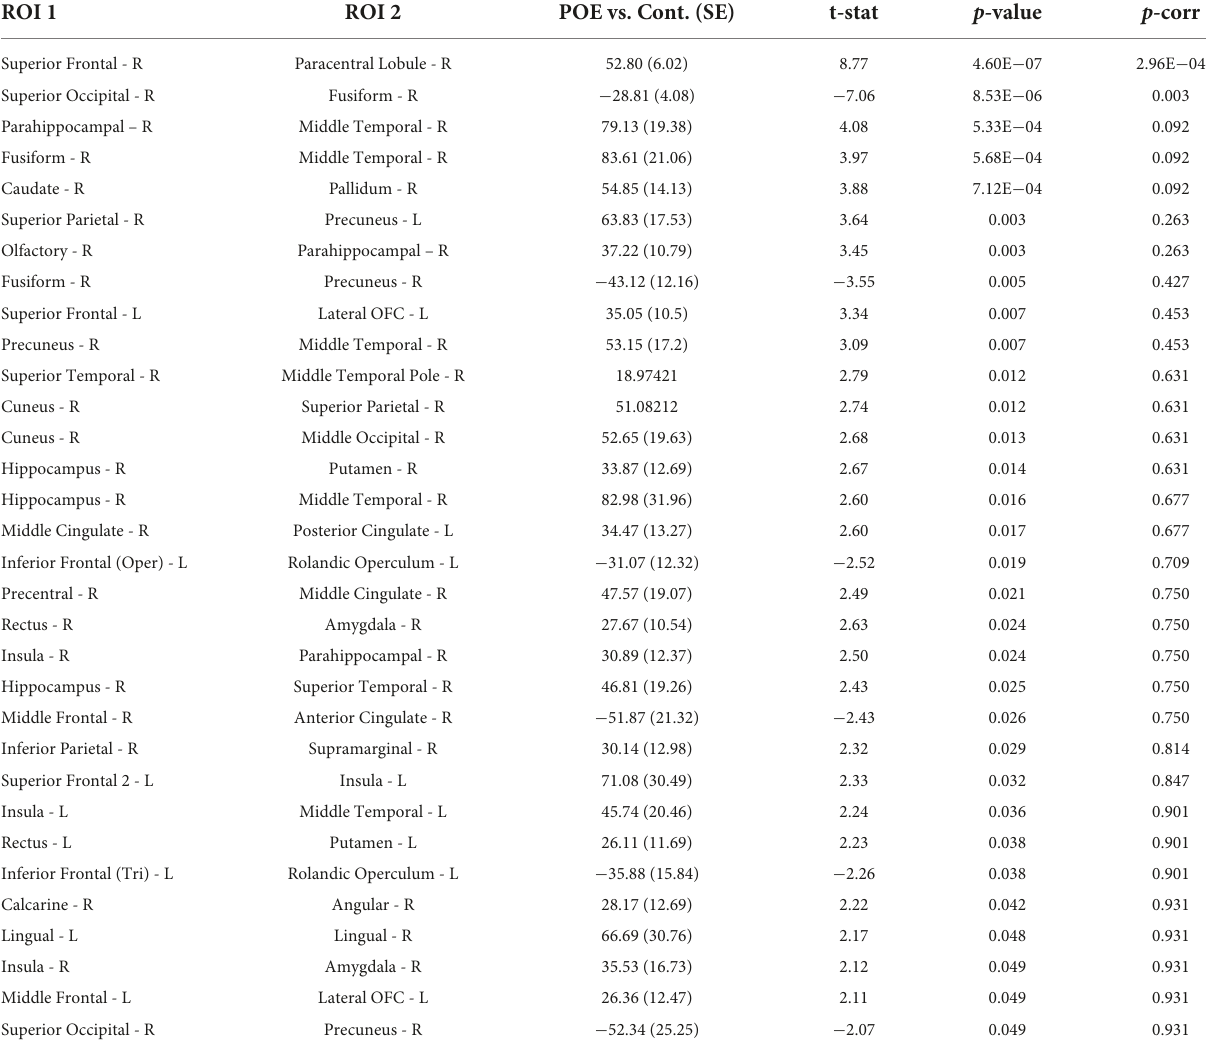
TABLE 2 Connectivity values between POE and opioid naïve infants based on fiber count. ROI 1 ROI 2 POE vs. Cont.